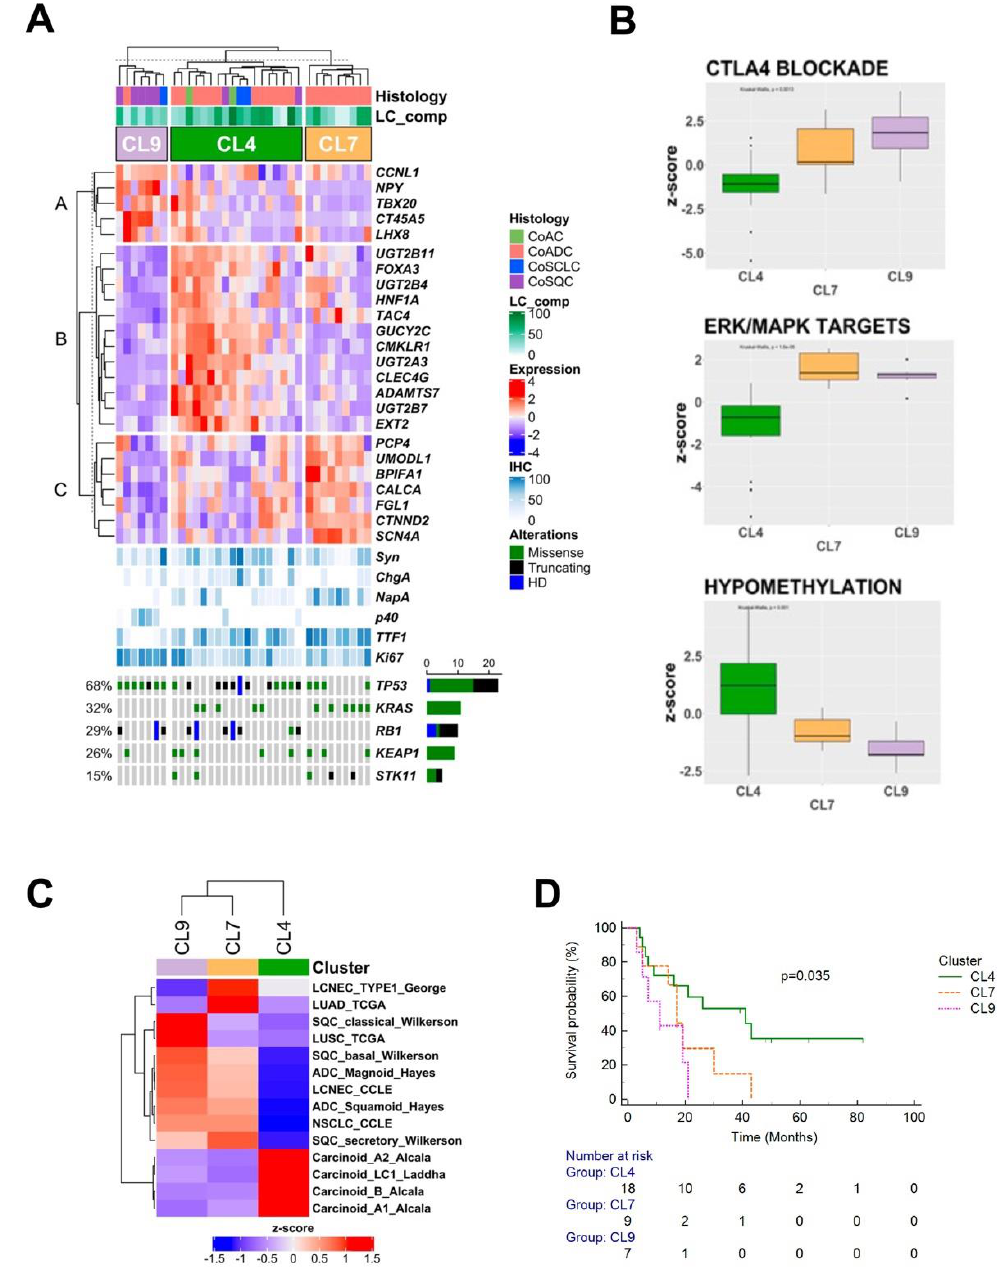
Figure 3. Molecular and clinico-pathological features of combined-LCNEC (CoLCNEC) principal clusters and their contextualization according to current molecular signatures available for lung cancer. ( A ) The upper heatmap shows expression of each characteristic gene included in 24-gene classifier produced following differential expression analysis and comparison of overexpressed genes between clusters. Each tumour sample is arranged in columns, annotated for the histological subtype and grouped according to their expression clustering class (CL4, CL7 and CL9). The central matrix shows immunohistochemical features while the bottom matrix shows selected genomic somatic alterations identified in each sample. ( B ) Box and whisker plots displaying the normalized enrichment z-score for the 3 most representative pathways for each identified molecular class. ssGSEA was used to obtain the enrichment score. ( C ) Comparison between expression profile of each molecular CoLCNEC cluster and currently available signatures of lung cancer. Tumour samples are arranged in columns, grouped according to their expression clustering class (CL4, CL7 and CL9), annotated for the histological subtype. ssGSEA was used to obtain the enrichment score, which represents the degree to which the profiles are similar (red) or different (blue). ( D ) Overall